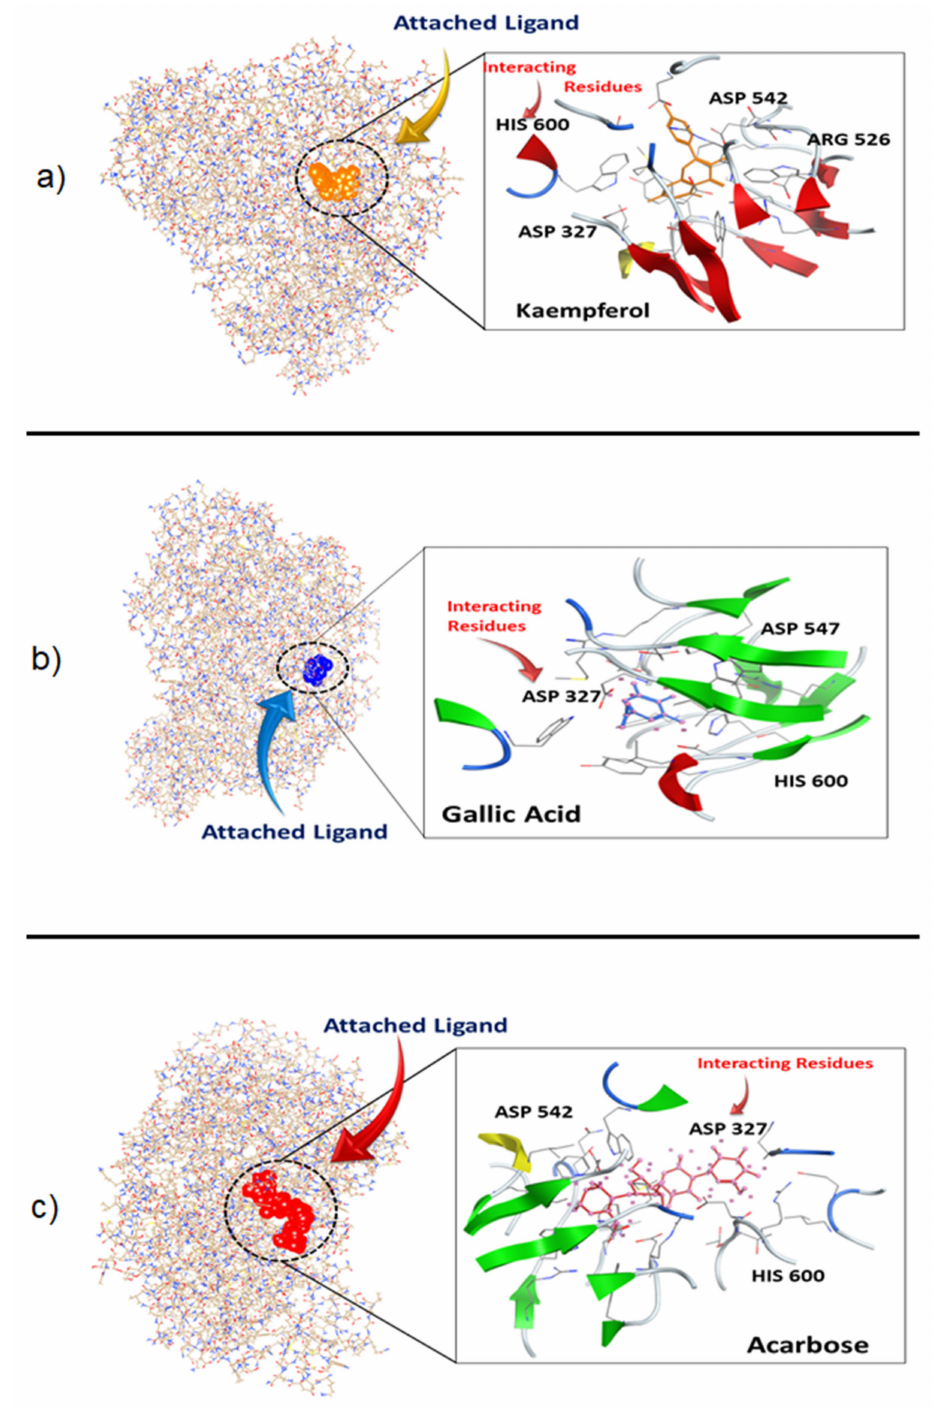
Figure 2. 2D and 3D illustration of selected docked complex: Kaempferol ( a ), Gallic Acid ( b ) and Acarbose ( c ) against Maltase-glucoamylase, an α -glucosidase